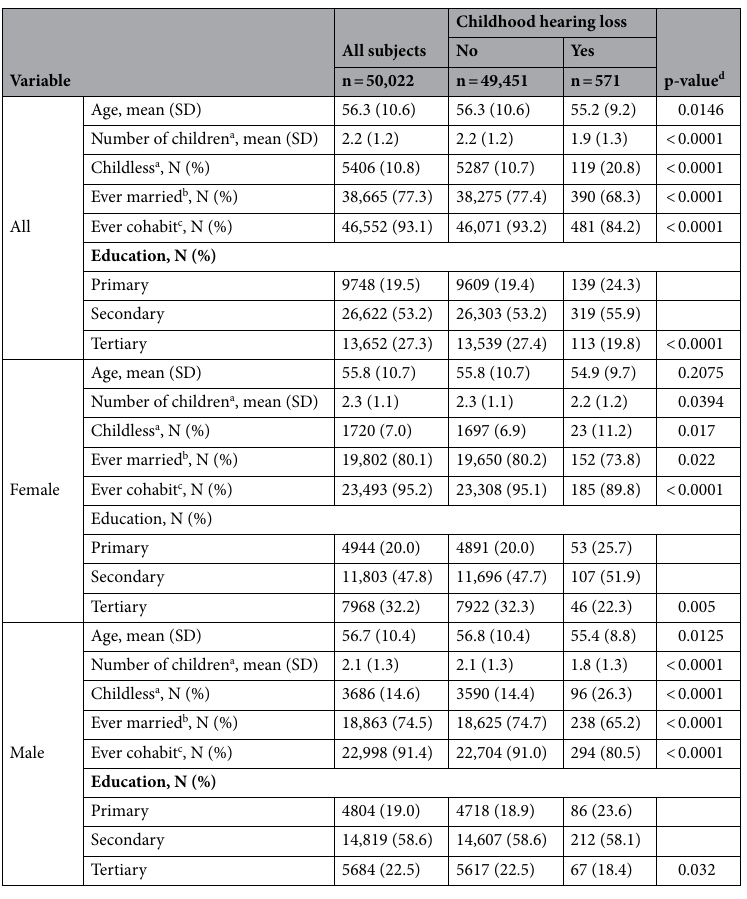
Table 1. Descriptive statistics. Hearing thresholds were defined as binaural pure-tone average (PTA) of four frequencies (0.5, 1, 2, and 4 kHz) measured in dB HL. Childhood Hearing loss was defined as PTA > 25 dB HL, moderate-severe profound hearing loss as PTA of > 40 dB HL, mild hearing loss as PTA 26–40 dB HL and slight hearing loss as PTA 16–25 dB HL. Only children diagnosed with permanent sensorineural hearing loss were included. Altogether 571 persons were classified with childhood hearing loss, 161 with moderate- severe profound sensorineural hearing loss, 410 with mild sensorineural hearing loss, and 489 with slight sensorineural hearing loss (see further details under “measures”). a Fertility observed in 2014. b Marital status = ’Ever married’ at least once in the period from 1975 to 2014. c Ever cohabit = ’Ever cohabit’ at least once in the period from 1975 to 2014. d T-test for means and Chi-Square test for frequencies.